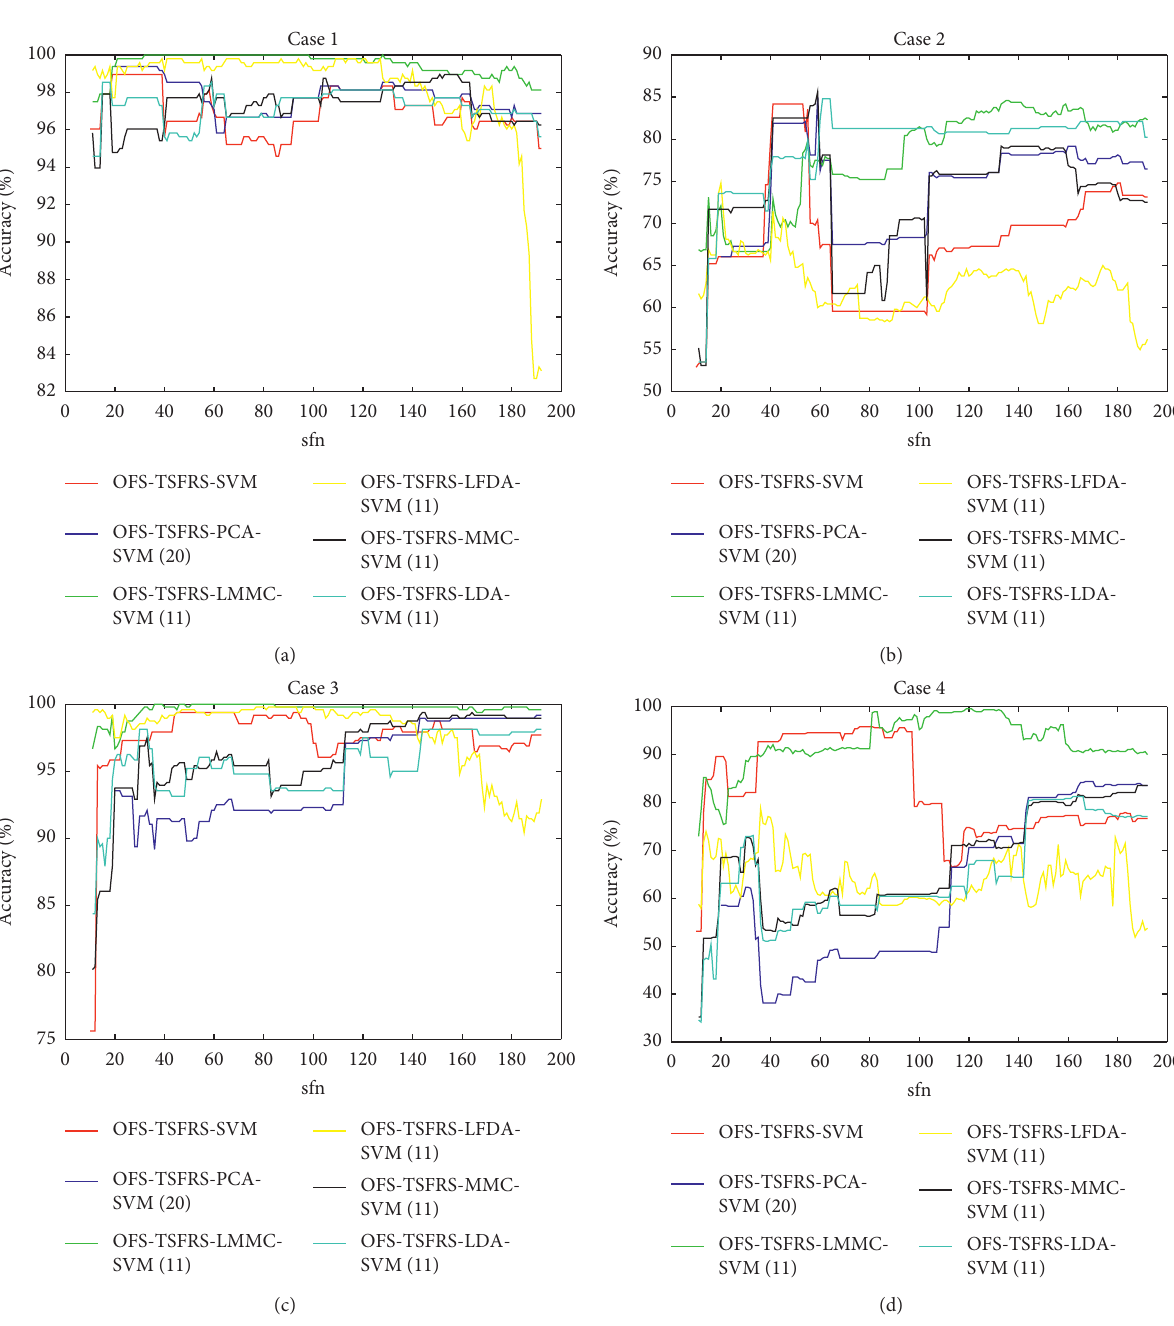
Figure 19: The curve representation of diagnosis results of models using WPT for the testing sets of two cases with the use of TSFRS and different dimensionality reduction methods. The output dimension sizes of PCA, LDA, LFDA, MMC, and LMMC are 20, 11, 11, 11, and 11,